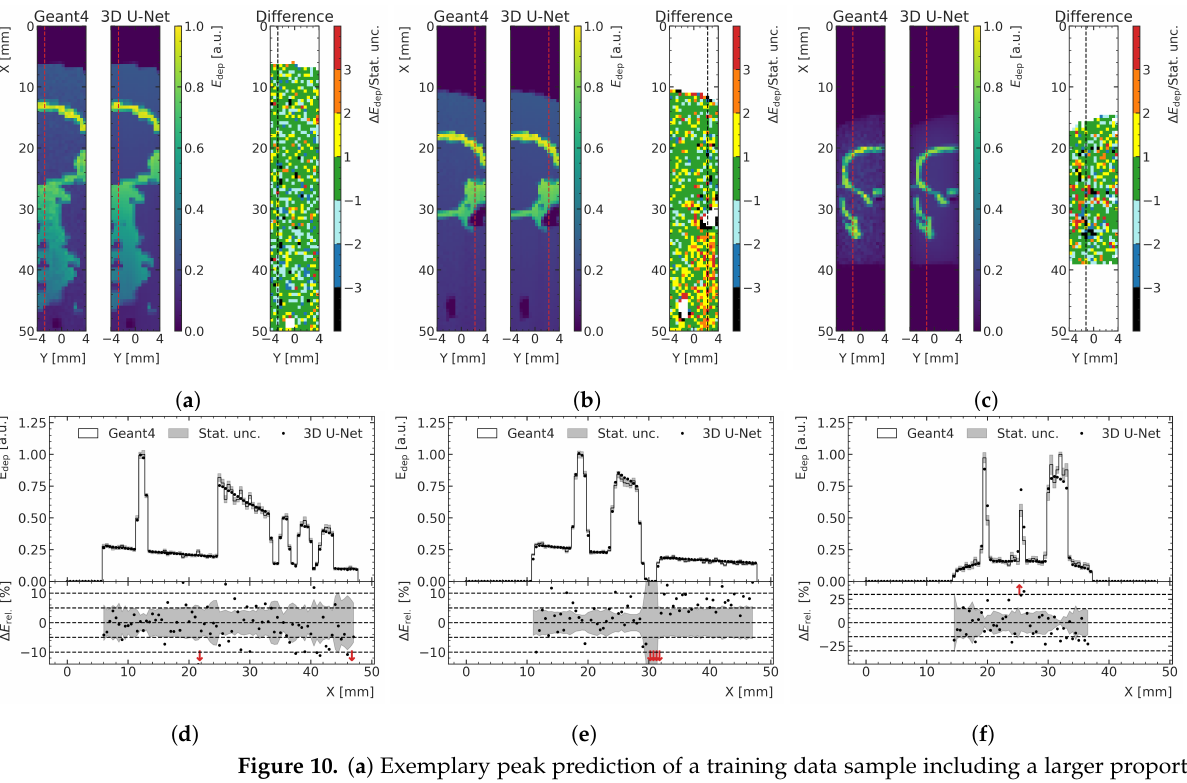
Figure 10. ( a ) Exemplary peak prediction of a training data sample including a larger proportion of spine, showing a 2D slice of MC simulation and ML prediction with the difference in units of statistical standard deviations. ( b , c ) show two worst-case prediction cases following different criteria. ( b ) Test data sample with the largest average deviation between ML and MC in units of standard deviations in the peak region. ( c ) Test data sample with the lowest fraction of voxels in which ML prediction with MC simulation agree within one standard deviation in the valley. ( d – f ) The depth–energy deposition curve at the position indicated with red (black) dashed line for each 2D representation shown in ( a – c ). Red arrows in the relative energy deviation subplot below indicate deviations larger than the shown